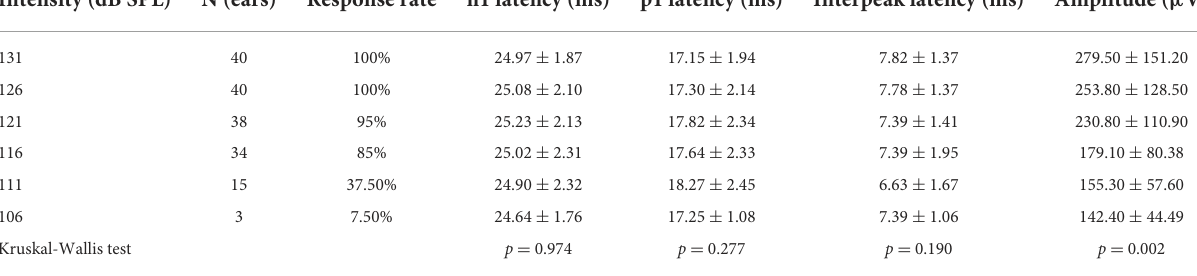
TABLE 4 The ACS-cVEMP with decreasing acoustic stimulation intensity in adults. Intensity (dB